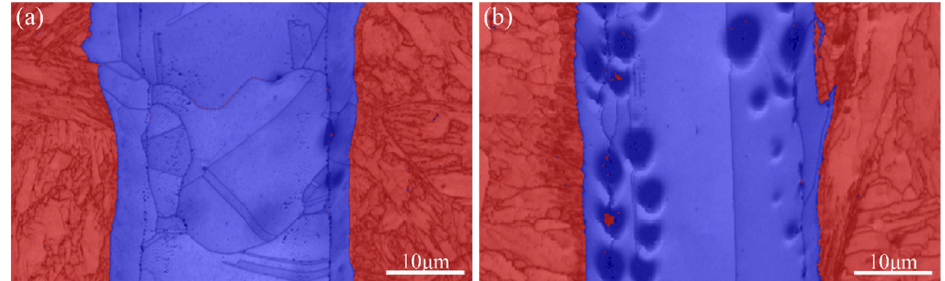
Figure 6. Phase map acquired by electron back-scattered diffraction (EBSD) for the joint regions ( a ) before and ( b ) after tempering treatment. Red represents α-phase and blue represents γ-phase.